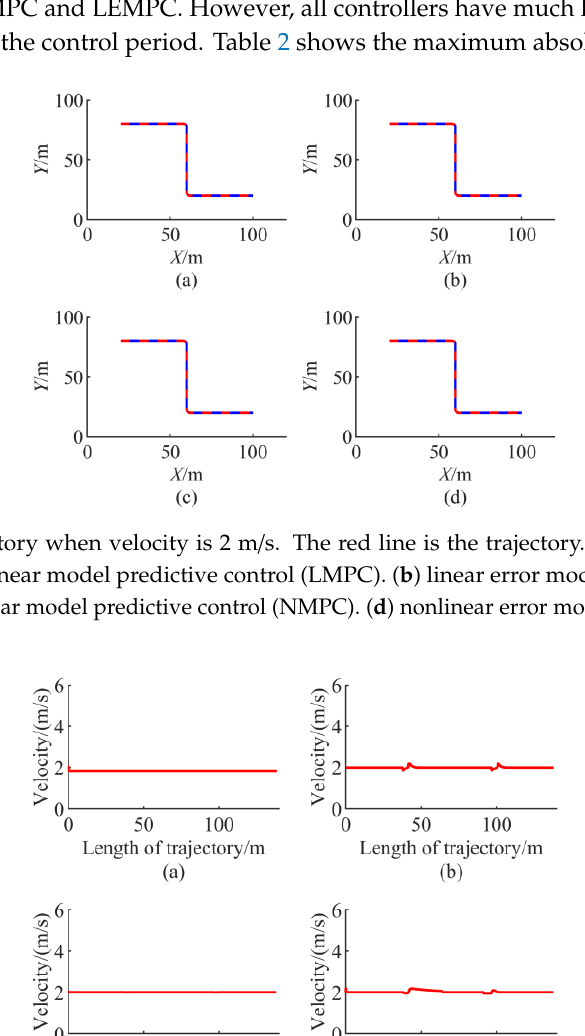
Figure 3. The heading angle speed when velocity is 2 m/s. ( a ) LMPC. ( b ) LEMPC. ( c ) NMPC. ( d ) NEMPC.